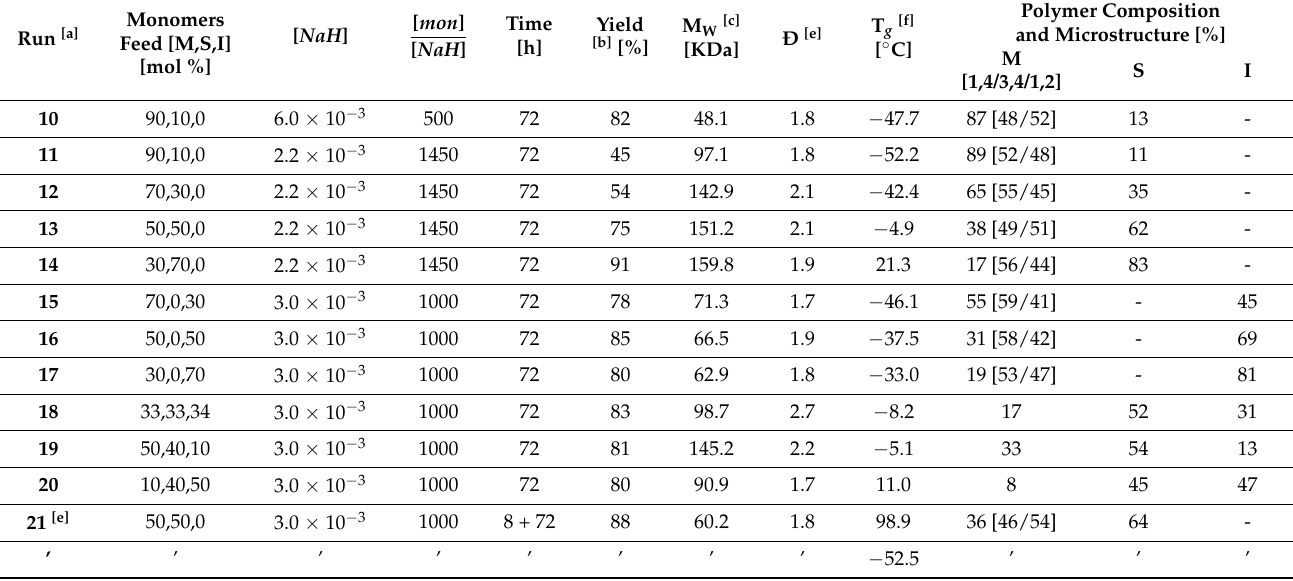
[a] Reactions were performed in toluene; monomers = 3.0; Al/Na = 0.8; THF/Na = 50. [b] Conversion was determined by gravimetry. [c] Determined by SEC in THF at 40 ◦ C, calibrated with polystyrene standards. [d] Determined by DSC. [e] Successive monomer additions (1st: styrene; 2nd: